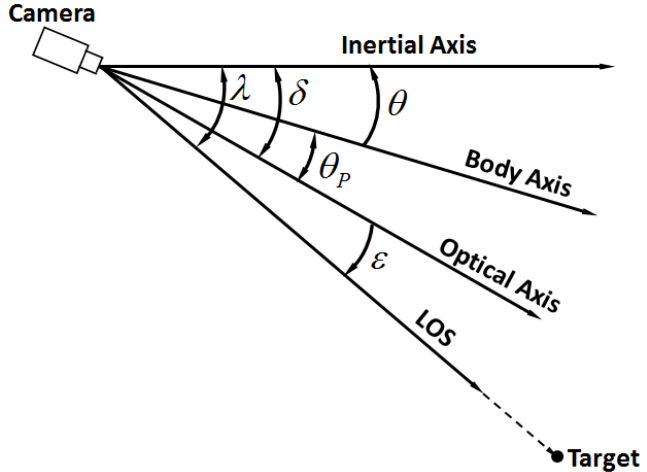
Figure 6. Angular geometry of the gimbal system.